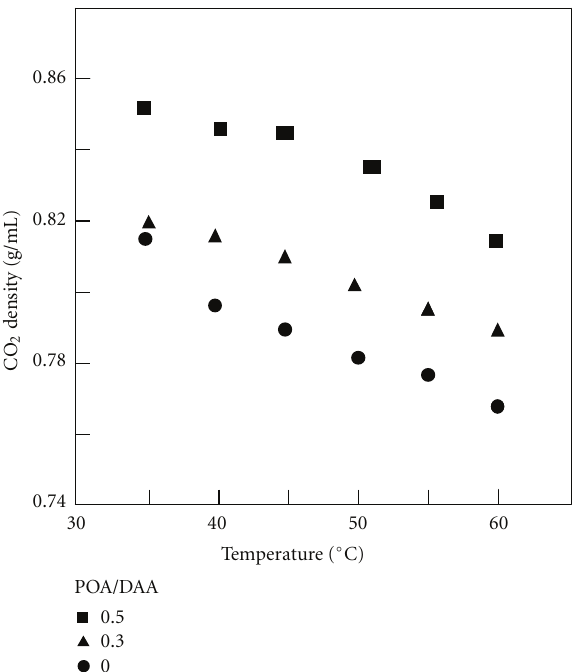
Figure 8: SEM images of the polymer particles obtained from the copolymer with a 6/4 POA/AA ratio at 45 ◦ C and the cloud point pressure − 1500 psi.